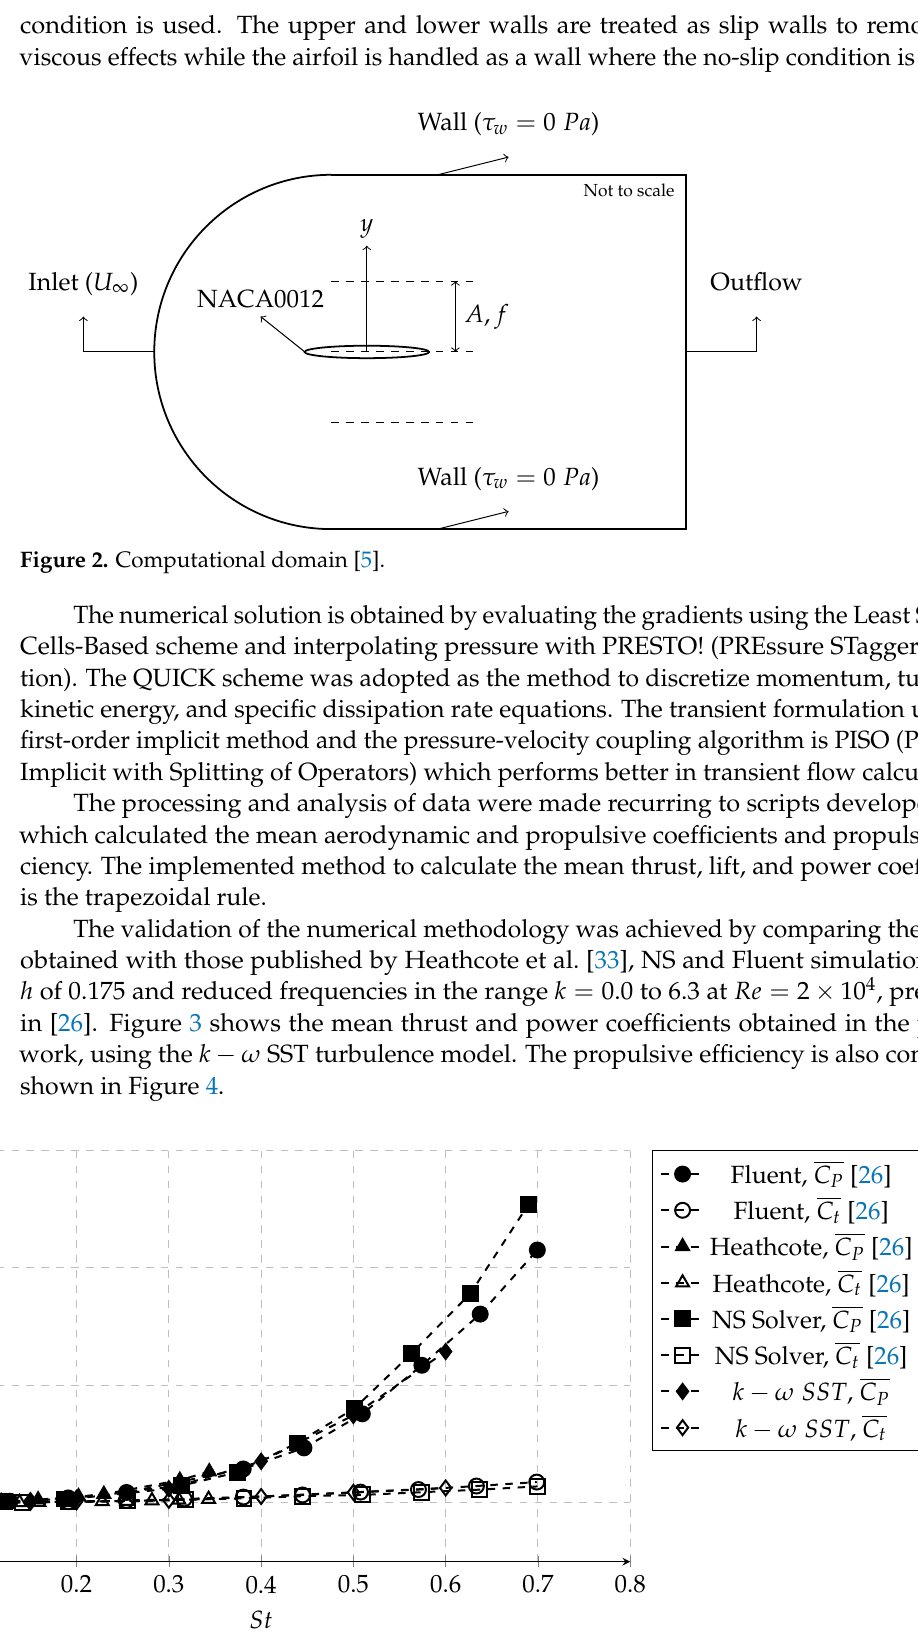
Figure 3. Mean thrust and power coefficients as a function of the Strouhal